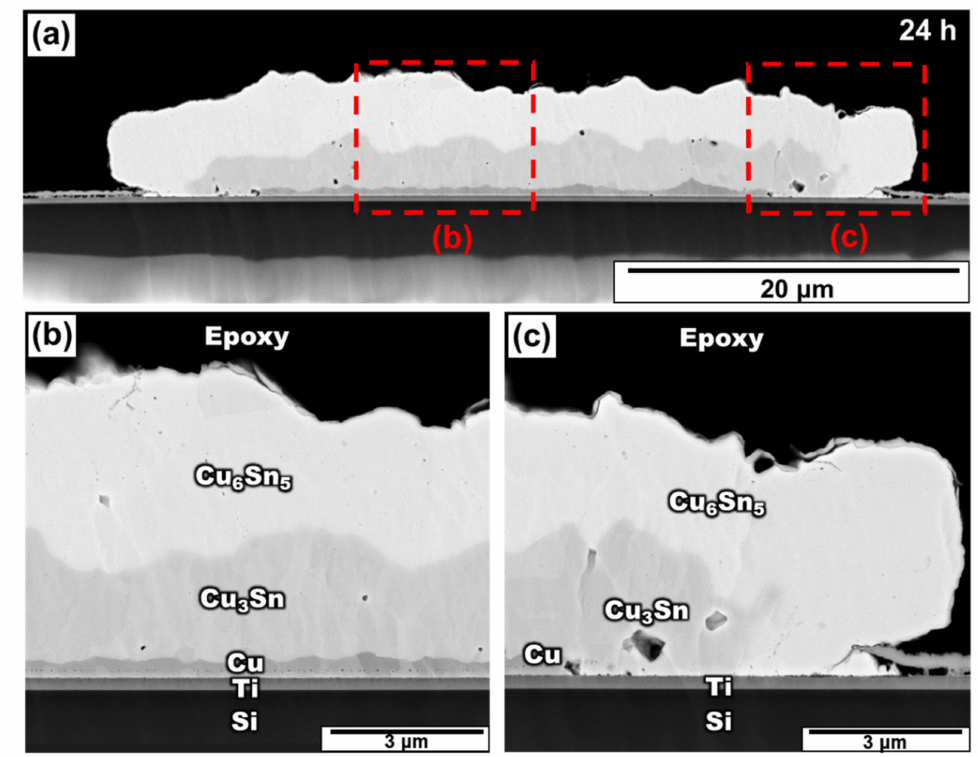
Figure 3. ( a ) Cross-section SEM image of the Sn/Cu micro-bump after aging at 200 ◦ C for 24 h and the zoomed-in image in a region near the ( b ) middle region and ( c ) right